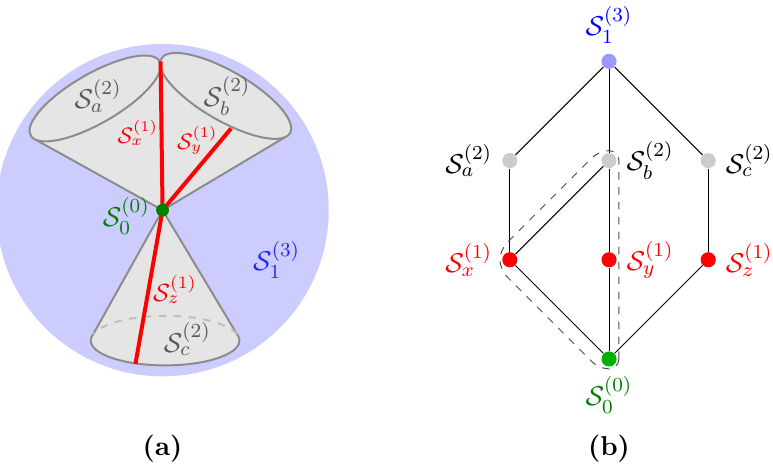
Figure 1. Cartoon of a 3-dimensional scale-invariant Coulomb branch, where each real dimension in the (cid:12)gure represents 1 complex dimension. The cones and lines are meant to extend to in(cid:12)nity; they are truncated here due to lack of space. Figure (a) shows a space where S ( d ) are the strata i of dimension d and i is a unique label. S (3) is the manifold of non-singular points of the 1